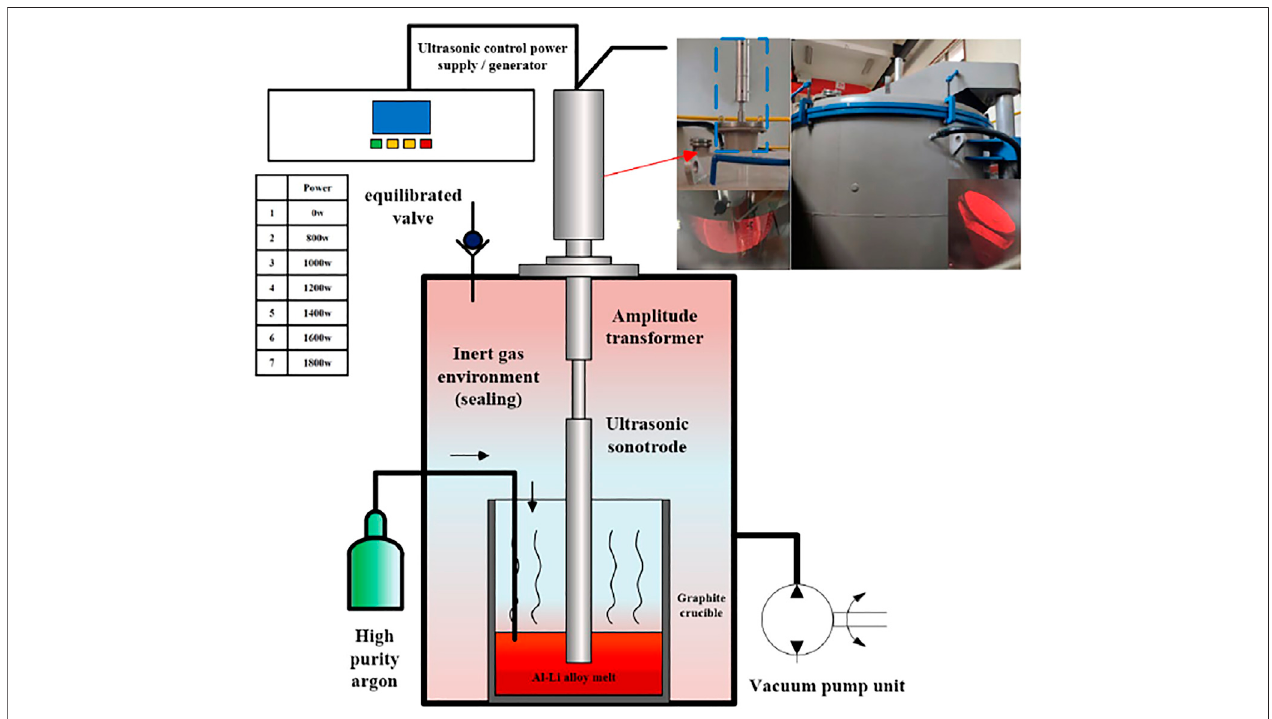
FIGURE 1 | Schematic diagram of the ultrasonic